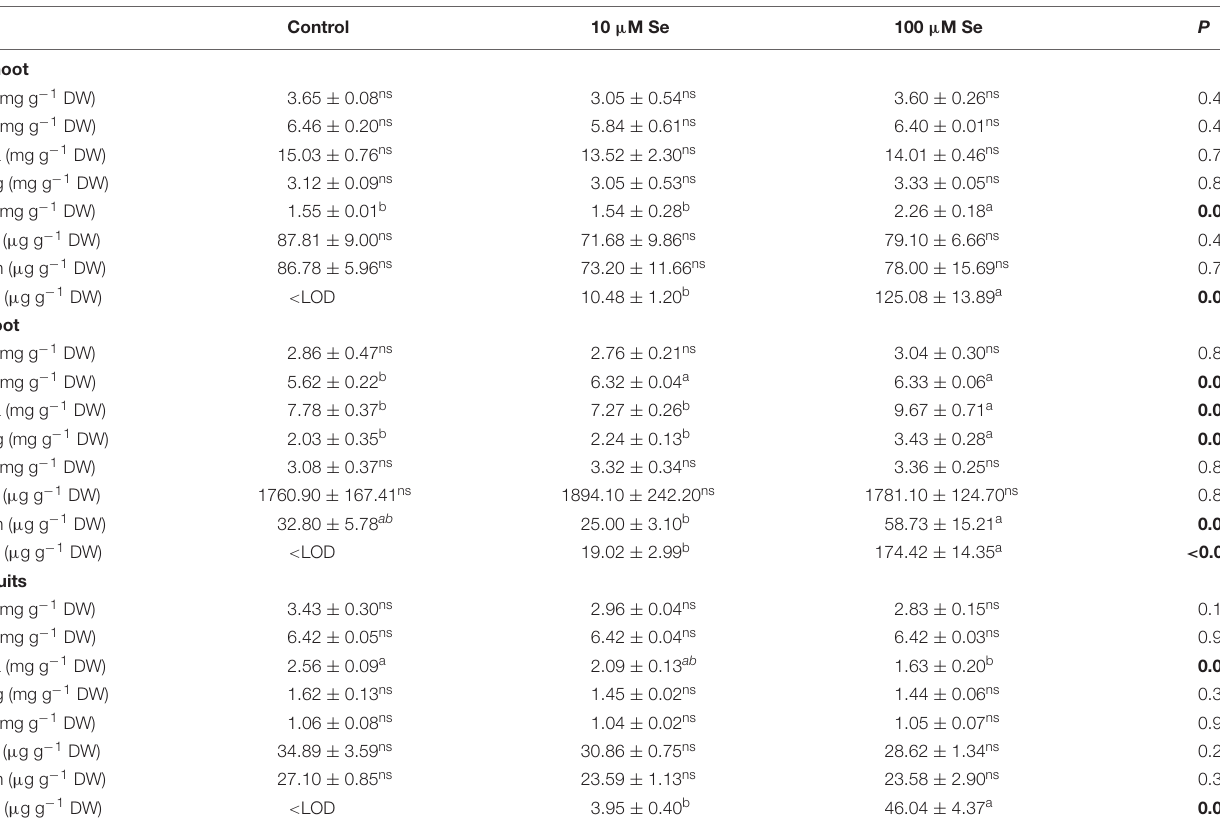
TABLE 2 | Macro- and micronutrients concentration in strawberry shoots, roots and fruits grown in a full nutrient (control) and a nutrient solution either supplied with 10 or 100 µ M